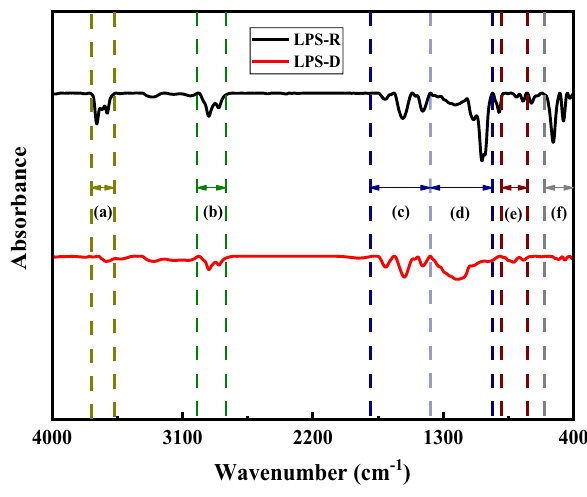
Fig. 1 FTIR spectra of LPS-R and LPS-D. a 3700 – 3600 cm